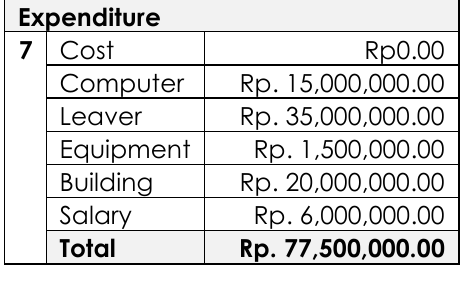
Table 5. Additional Cost